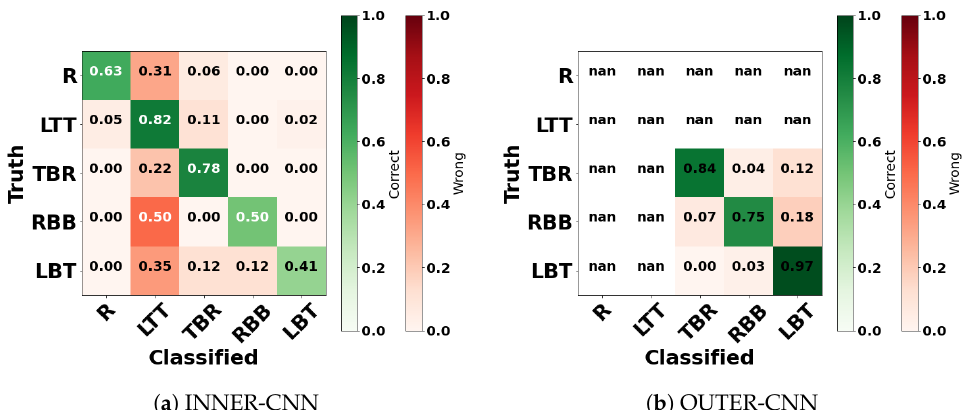
Figure 12. Normalized confusion matrices for the self-tests of ( a ) the INNER-CNN and ( b ) the